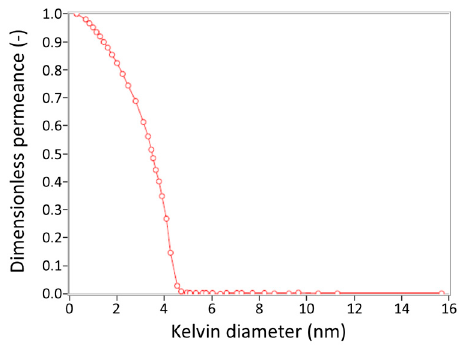
Figure 3. The nanopermporometry measurements of γ -alumina layer on the asymmetric substrate.